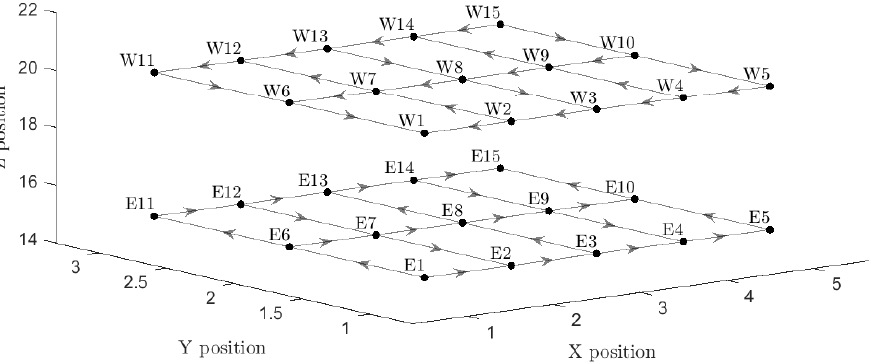
Figure 1. An example of the proposed route network-based urban airspace structure